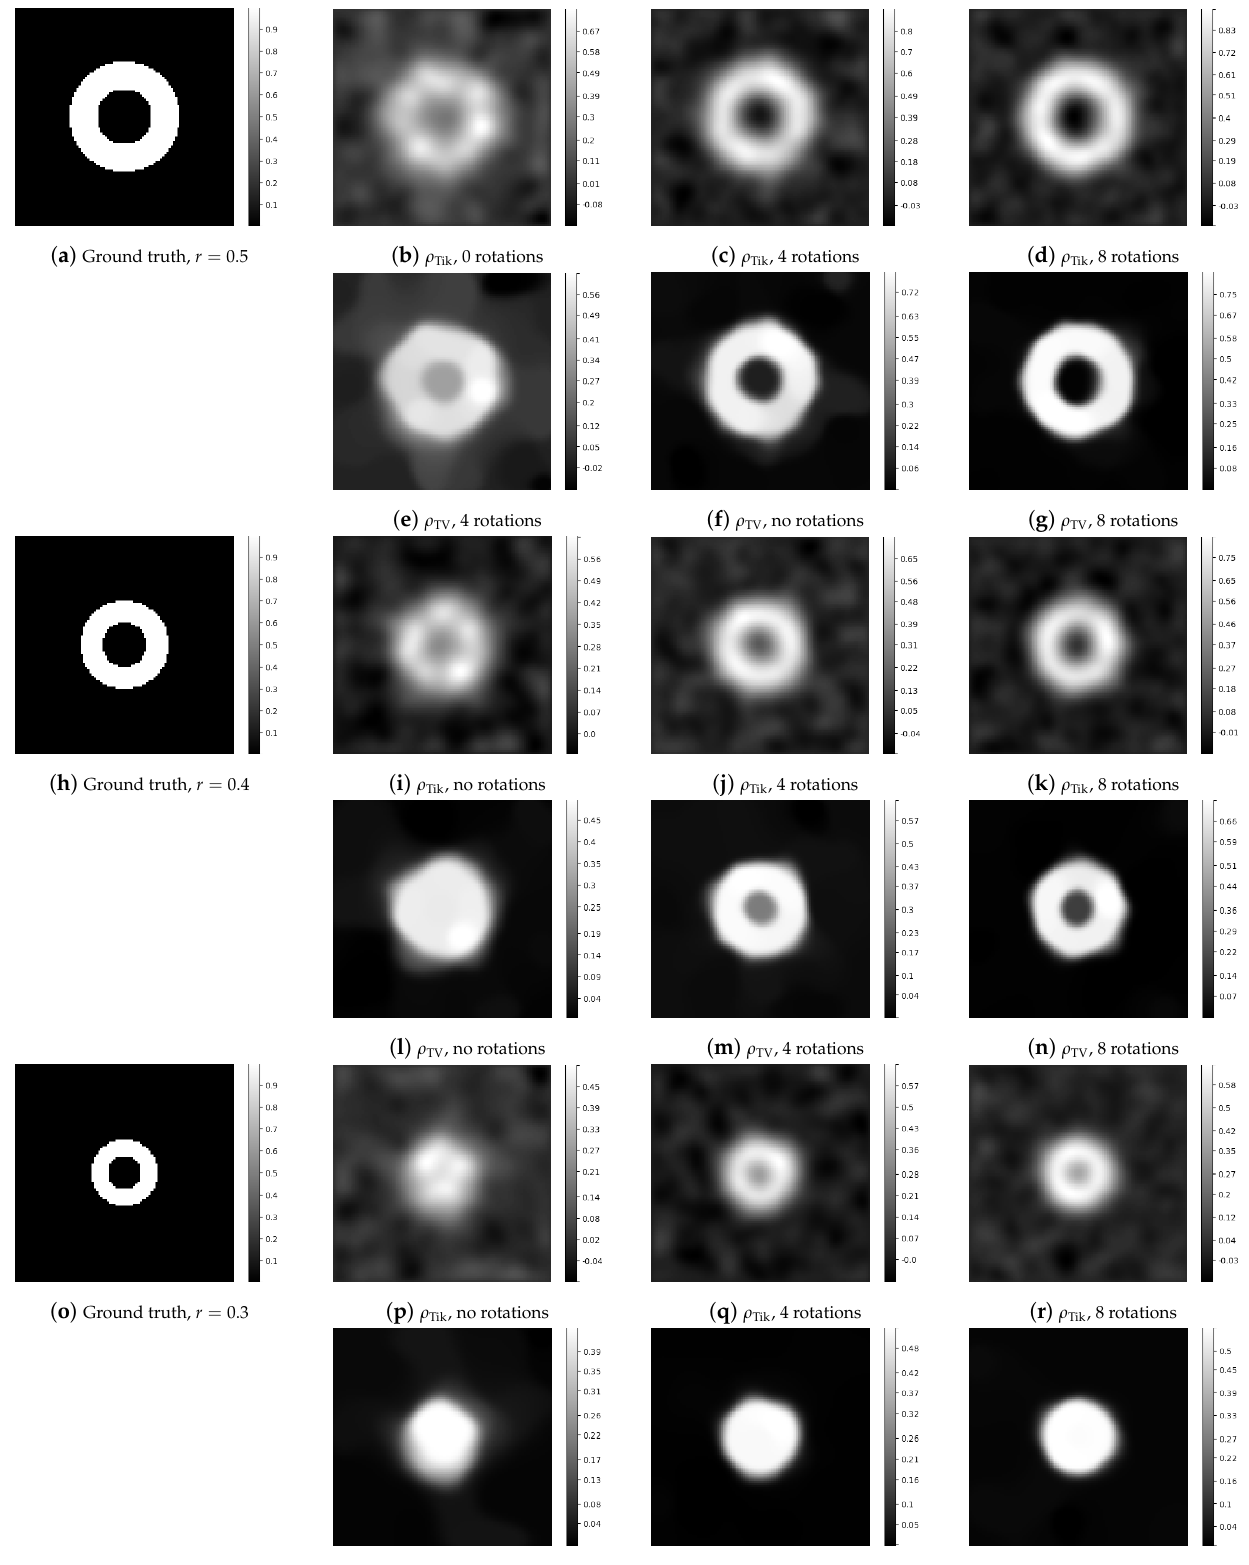
Figure 5. Effect of decreasing the size of the object. The ground truth consists of circular rings of decreasing size. First row. Trace fields u = trace A [ ρ ] (output of Stage 1) obtained with increasing number of rotations 0,4,8. Second and third row. Reconstruction results ρ Tik using Tikhonov ( second row ) and TV smooth ( third row ) regularized deconvolution in Stage 2 with increasing number of